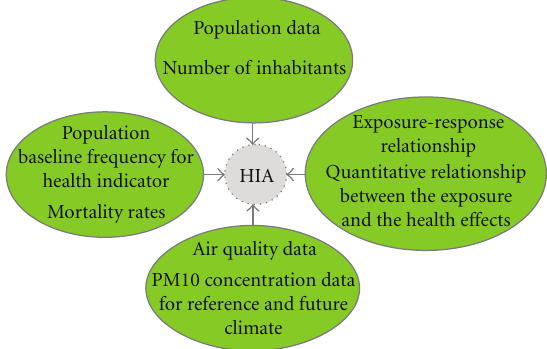
Figure 1: Schematic representation of the input information re- quired by the health impact assessment performed in this study.